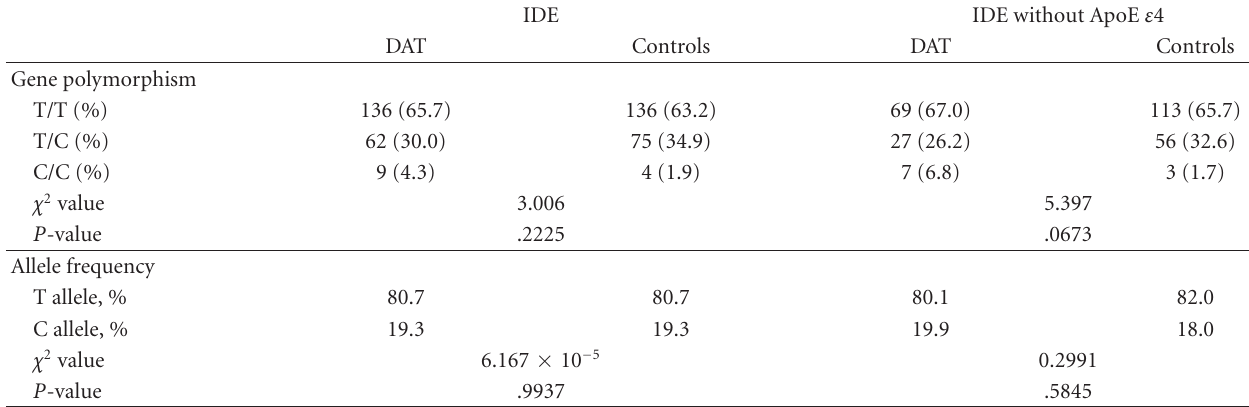
Table 1: Genotype distributions and allele frequencies of IDE gene polymorphism in DAT patients and controls after stratification according to ApoE ε 4 allele.